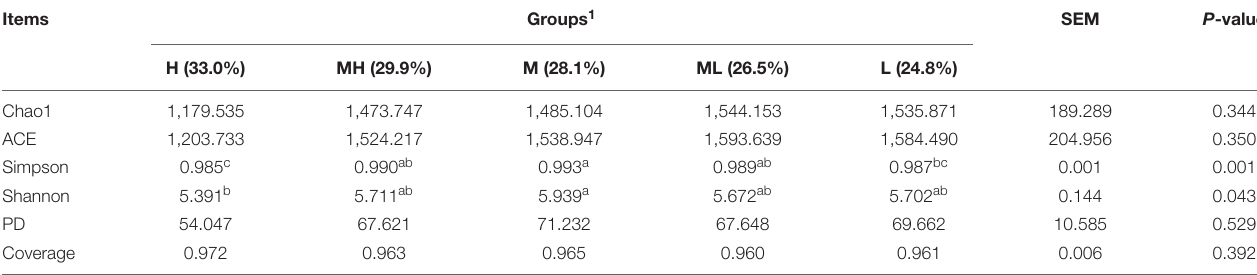
TABLE 4 | Effects of dietary peNDF 1 . 18 level on alpha diversity indexes of rumen bacteria in goats. Items